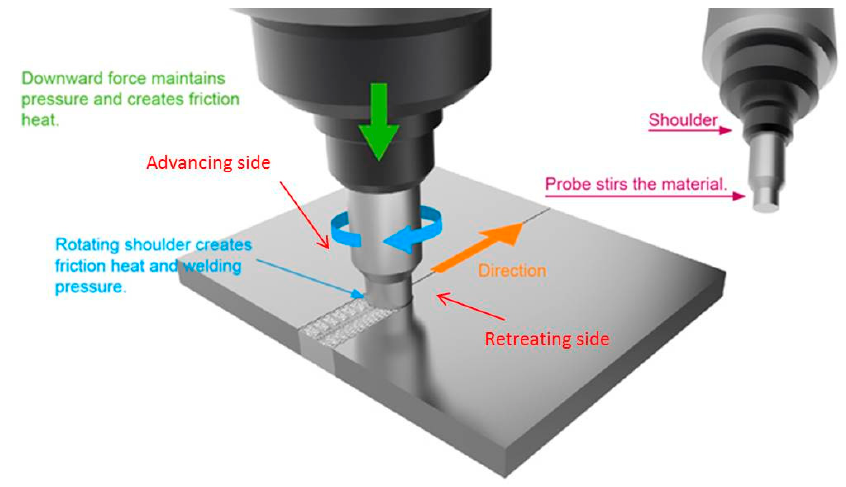
Figure 1. Schematic diagram of the FSW process.